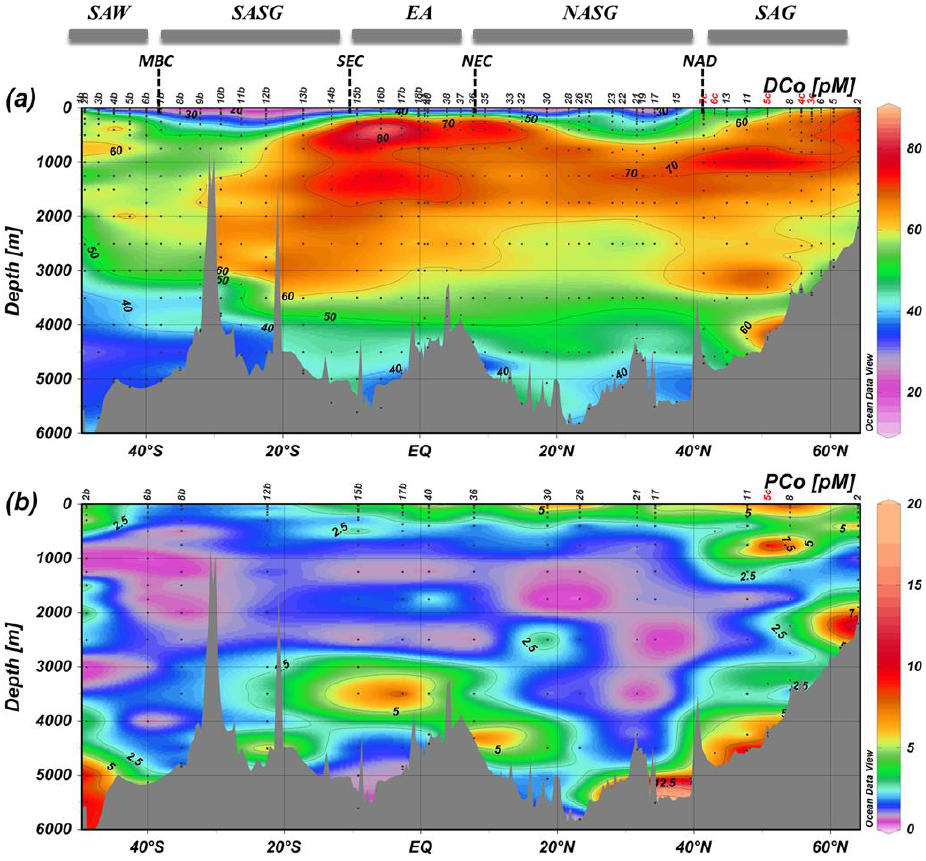
Fig. 4. Interpolated vertical sections of (a) dissolved cobalt ( D Co,pM) and (b) apparent particulate cobalt ( P Co,pM) based on 675 analyses for D Co and 203 analyses for P Co along the GEOTRACES-A02 section in the western Atlantic. Stations sampled during leg 4 are labeled in red. The domains of SAG, NASG, EA, SASG and SAW are characterized by the macronutrients concentrations and by the surface currents (e.g., NAD, NEC, SEC, and